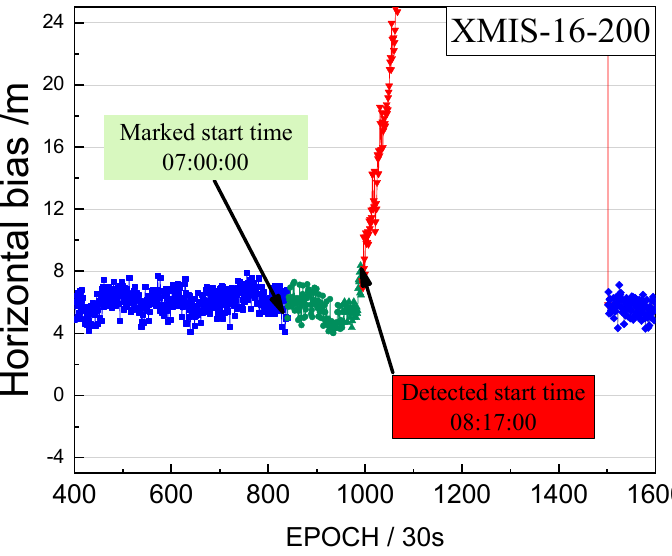
Figure 7. The bias between pseudo-range SPP coordinates and the SINEX coordinates (in horizontal) on doy 200, 2016.